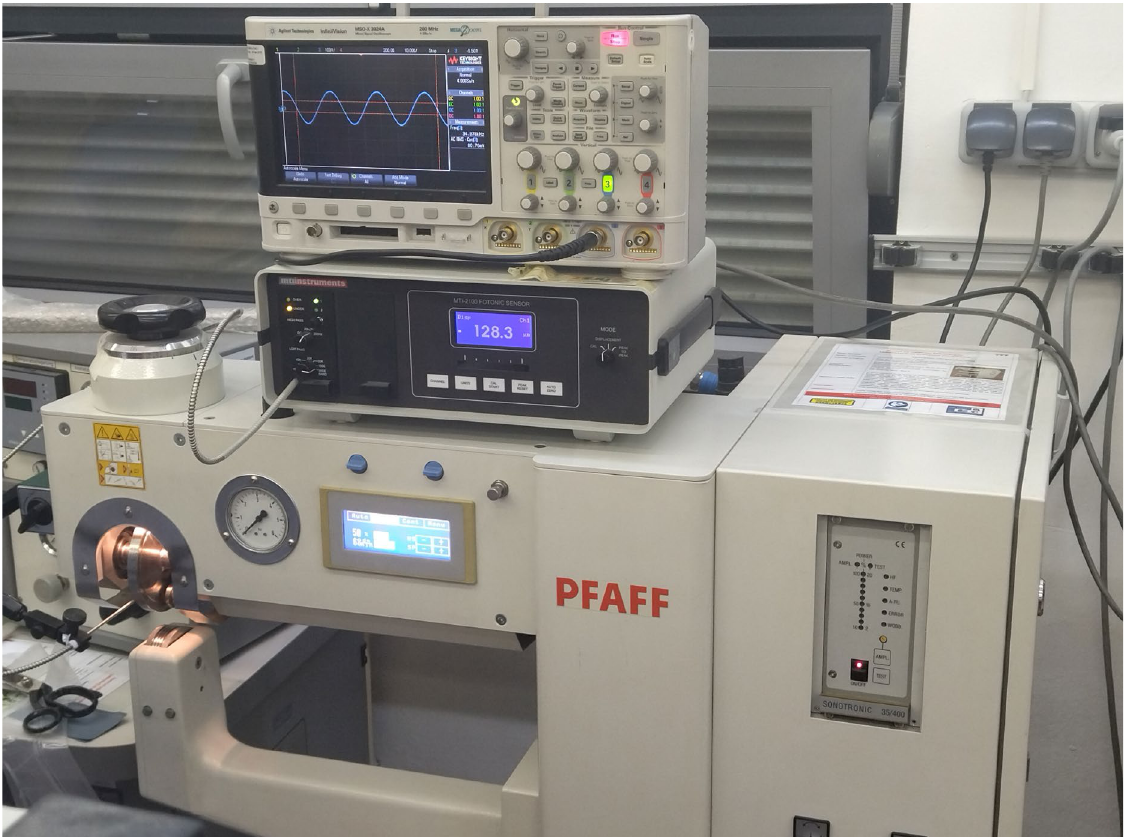
Figure 3. A measuring setup on the machine for welding polymer materials.